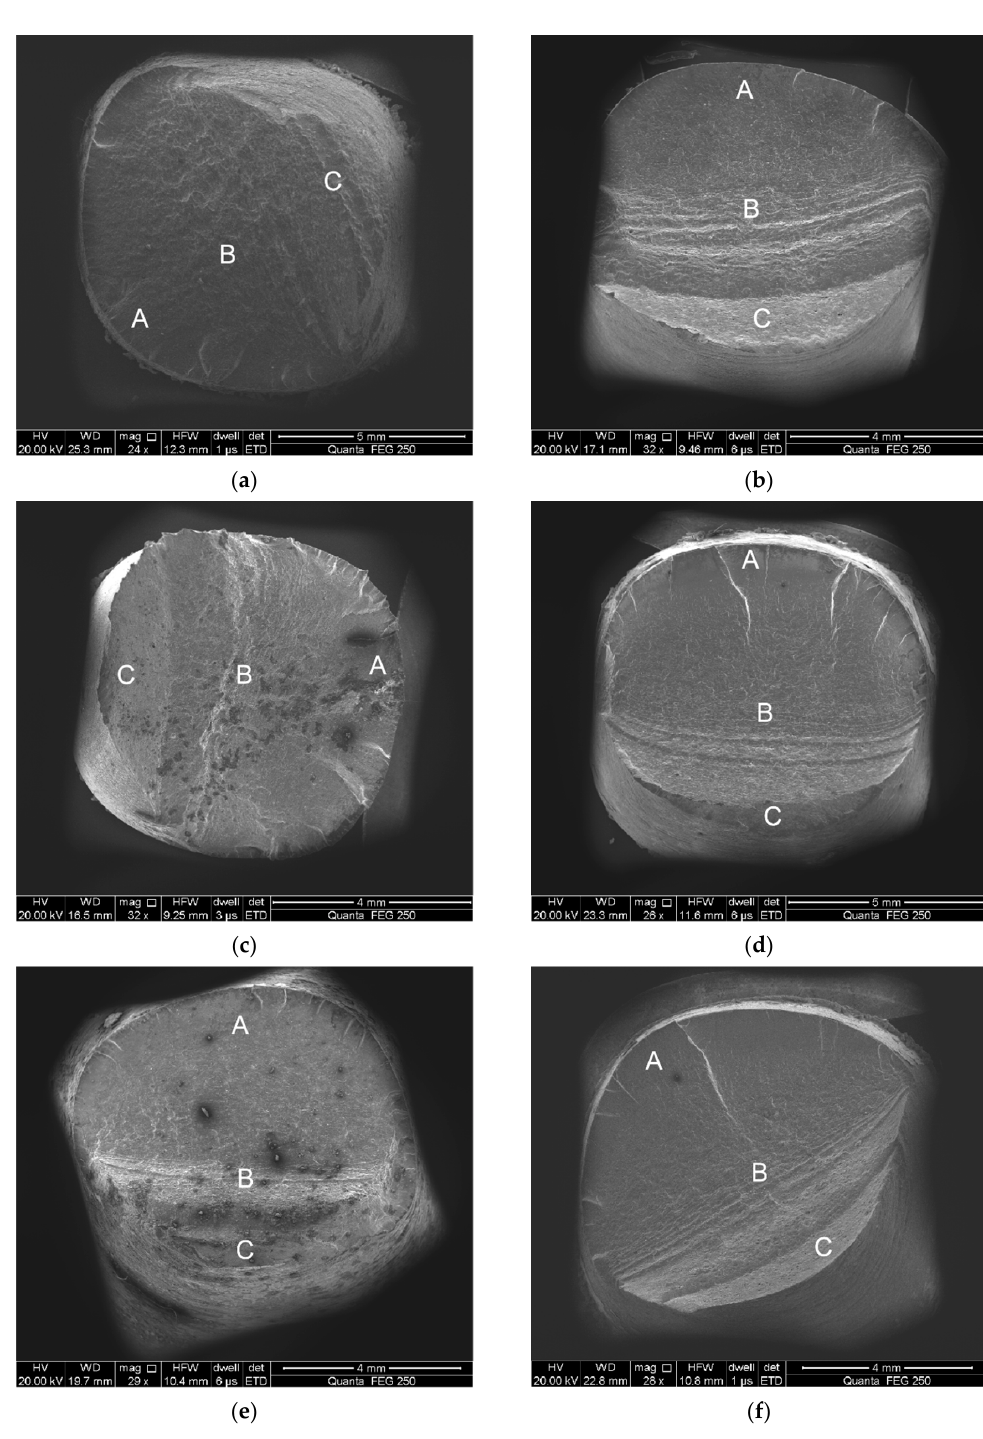
Figure 6. Overview of the fatigue fracture surface ( a ) ±0.5% (air), ( b ) ±0.2% (air), ( c ) ±0.5% (mixed chloride salt), ( d ) ±0.2% (mixed chloride salt), ( e ) ±0.5% (mixed sulfate salt), and ( f ) ±0.2% (mixed chloride salt), ( d ) ± 0.2% (mixed chloride salt), ( e ) ± 0.5% (mixed sulfate salt), and ( f ) ± 0.2% (mixed sulfate salt). sulfate